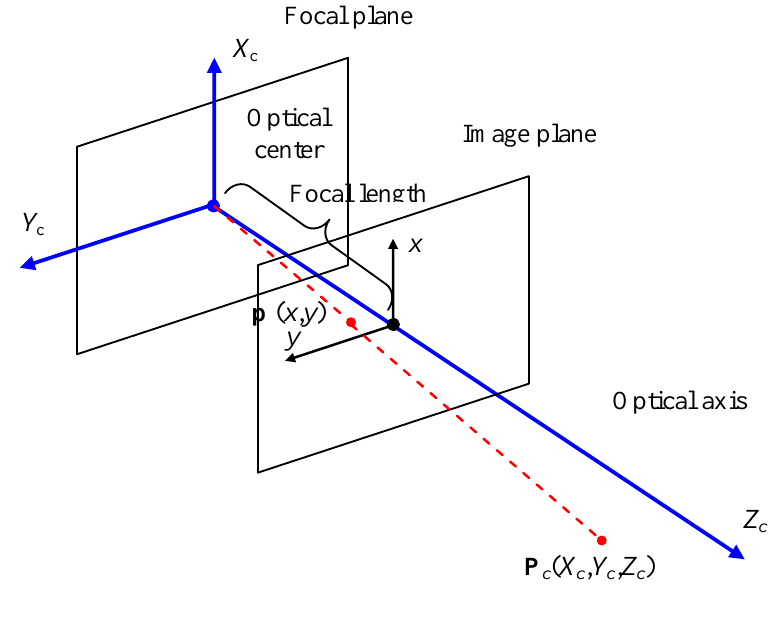
Figure 4. Geometric model of a pinhole camera. In this model the optical center coincides with the origin of the camera coordinate system (  reference system ( x , y ) is drawn in black